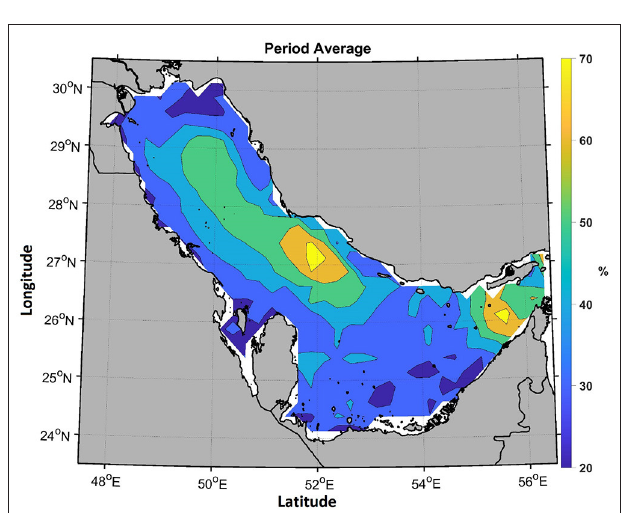
FIGURE 6 | Percentage SST changes associated with heat exchange at air-sea interface. SST: sea surface temperature.